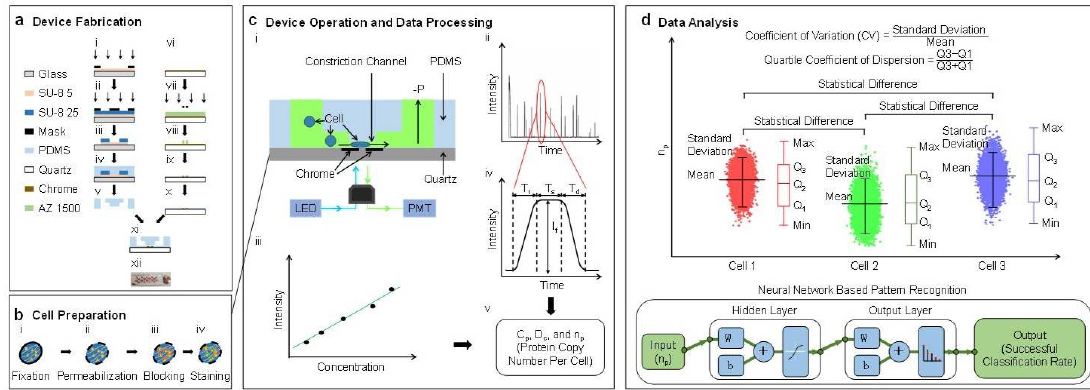
Figure 1. Methodology. Working flowchart for the characterization of the absolute copy number of β-actin proteins at the single-cell level. Key steps include device fabrication ( a ); cell preparation ( b ); device operation & data processing ( c ) and data analysis ( d ). In this study, single cells stained with fluorescence labelled antibodies are forced to deform through a polymeric constriction channel (microfabricated channel with a cross-sectional area smaller than a cell) where the obtained fluorescent profiles are translated to cellular sizes and absolute copy numbers of specific intracellular proteins. Coefficients of variation and quartile coefficients of dispersion were quantified to determine the varied expressions of β-actin proteins among individual cells within the same cell. Statistical +analysis and neural network based pattern recognition were conducted to determine the varied expressions of β-actin proteins among different cell types.